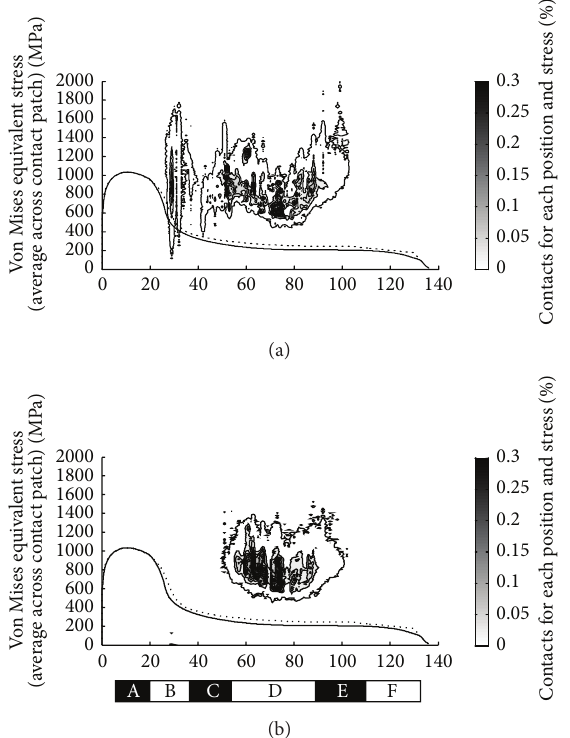
Figure 3: Distribution of contact conditions across a wheel profile for leading (a) and trailing (b) axle. The y axis shows the Von Mises equivalentstress(basedontheaveragestressforeachcontactpatch). Contours indicate the prevalence of contacts under each condition, with darker shades of grey representing a higher percentage of contacts, such as the frequent contacts in the centre of the tread at low stress. Higher stresses occur in other locations across the wheel profile when leading, but these are less frequent. On the trailing wheelset, the stress cycles are mostly in the running band (Region D) and with moderate stress levels. Approximately half the cycles on a given wheelset are experienced when it is leading the bogie, and half when it is the trailing wheelset.